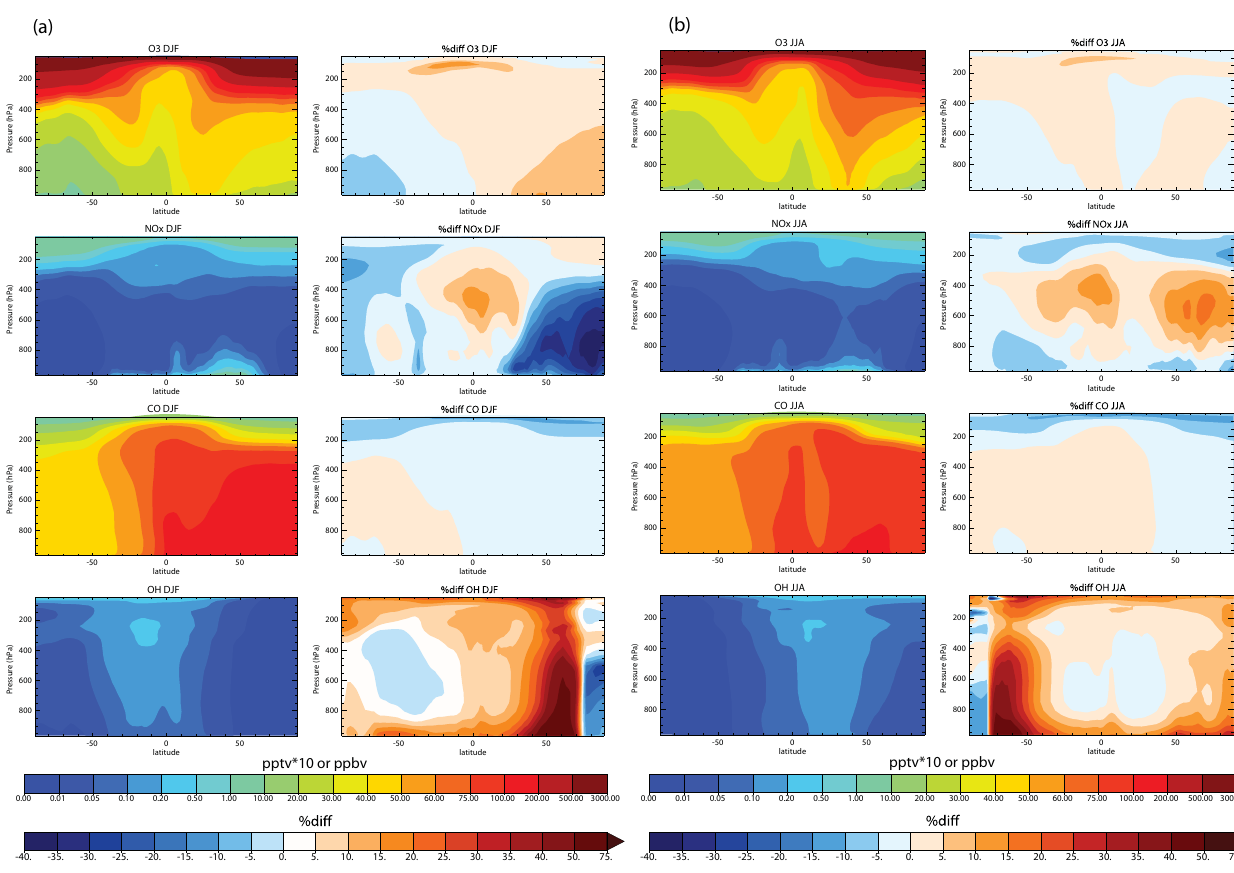
Fig. 5. (a) The zonally averaged distribution of O 3 , NO x , CO and OH for season DJF during 2006 as calculated by the Modified Band Approach. The mixing ratio of OH is scaled up for clarity. The right panels show the corresponding relative differences against the Band Approach, where the differences is calculated as (2 × (MBA-BA)/(MBA-BA)) × 100. (b) As for (a) except for season JJA.